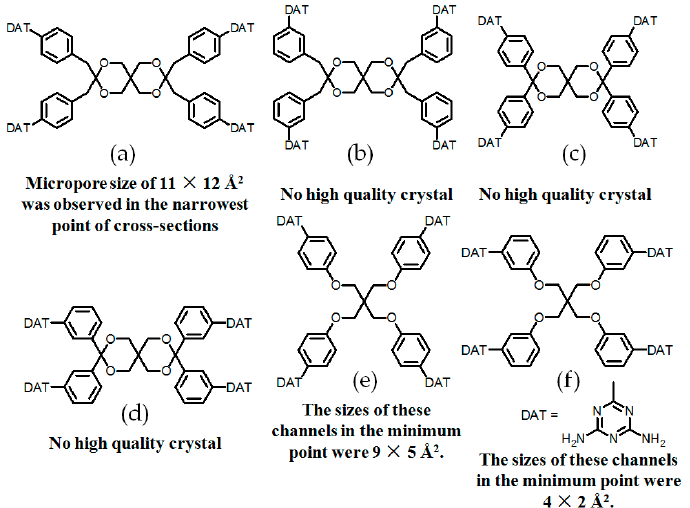
Figure 22. ( a ) Structure of building motif 24a ; ( b ) Structure of building motif 24b ; ( c ) Structure of building motif 24c ; ( d ) Structure of building motif 24d ; ( e ) Structure of building motif 25a ; ( f ) Structure of building motif 25b .